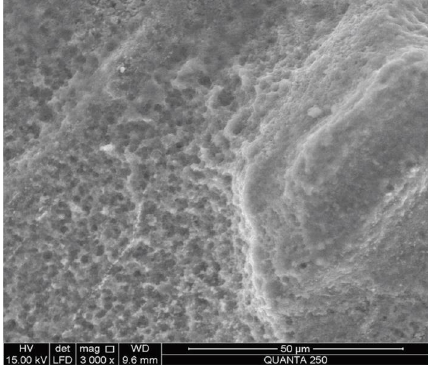
F IGURE 8: Corrosion pro fi le of magnesium alloy plate after removal of degradation products with chromic acid.